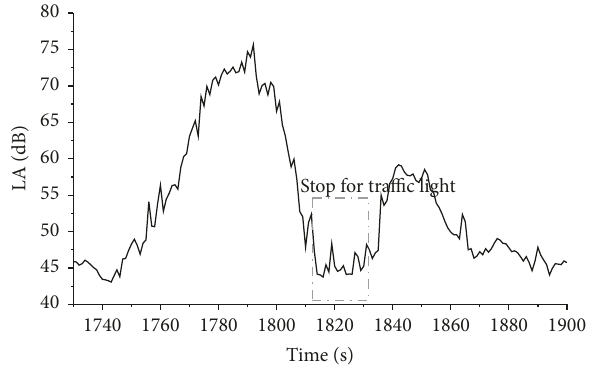
Figure 7: Example of selection of measuring time interval for a whole train passage (leaving out).